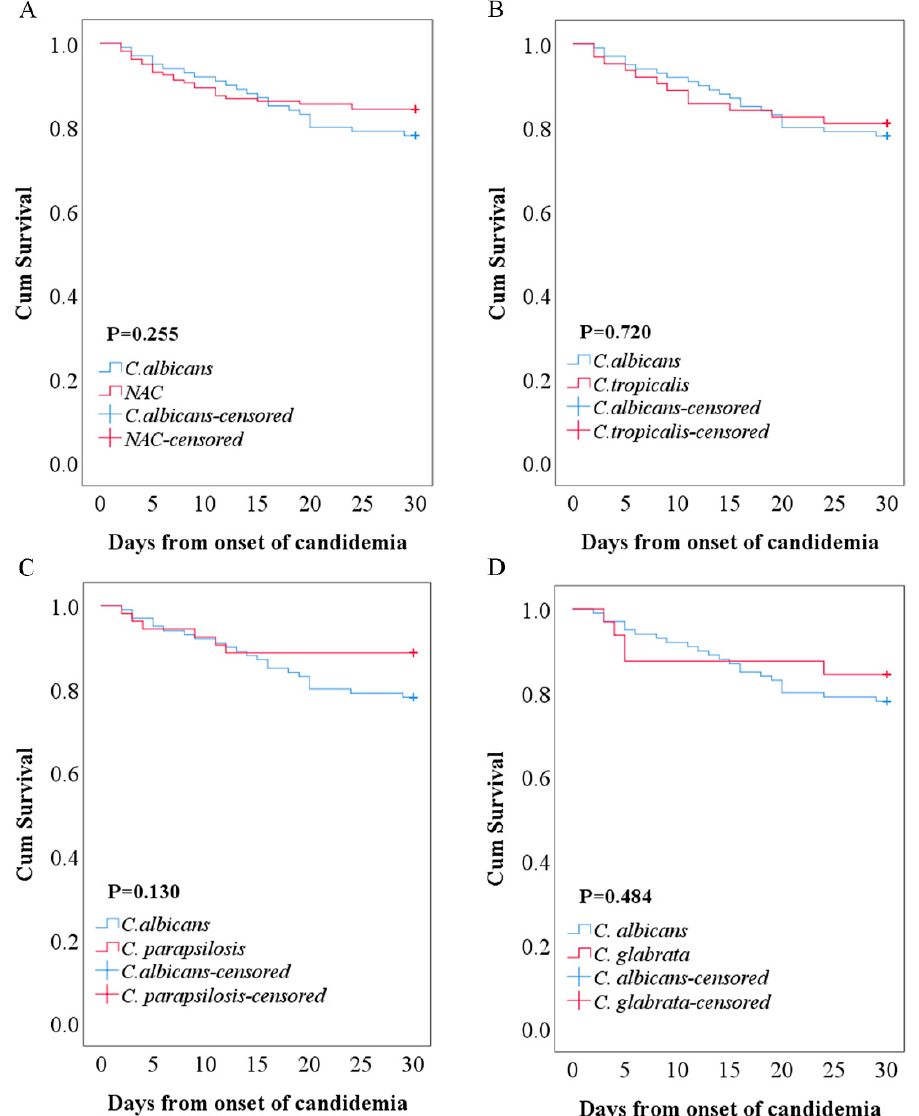
Figure 4. Kaplan–Meier survival curve of patients with C. albicans and non-albicans candidemia. Survival curve for 100 C. albicans vs. 159 non-albicans Candida candidemia ( A ), 100 C. albicans vs. 63 C. tropicalis candidemia ( B ), 100 C. albicans vs. 53 C. parapsilosis candidemia ( C ), 100 C. albicans vs. 32 C. glabrata candidemia ( D ).